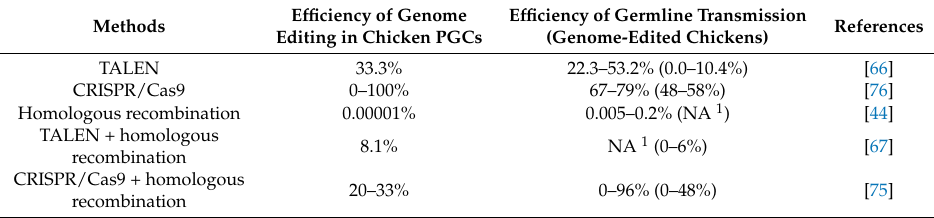
Table 1. Comparison of programmable genome editing technologies adopted in avian